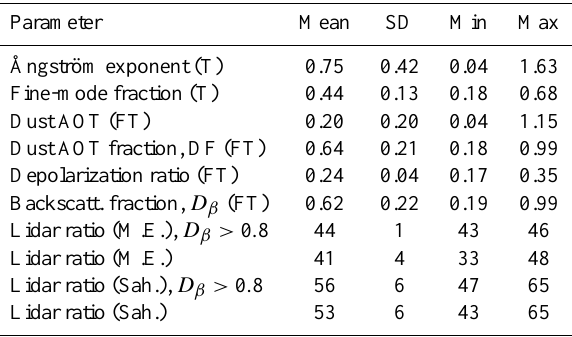
Table 1. Desert dust layer statistics for 49 outbreaks (2010–2013): AERONET Ångström exponent (440–870nm) and fine-mode frac- tion (ratio of 500nm fine-mode AOT to AOT) for the tropospheric vertical column (T), and lidar-derived 532 nm dust AOT for the free troposphere (FT), dust fraction DF (Eq. 3), the dust-layer mean particle linear depolarization ratio (532nm), the backscatter frac- tion D β (Eq. 1), and the different lidar ratios (for Middle East, M. E., and Saharan dust). Mean value and standard deviation (SD) are given together with the range of observed values (from minimum to maximum value).